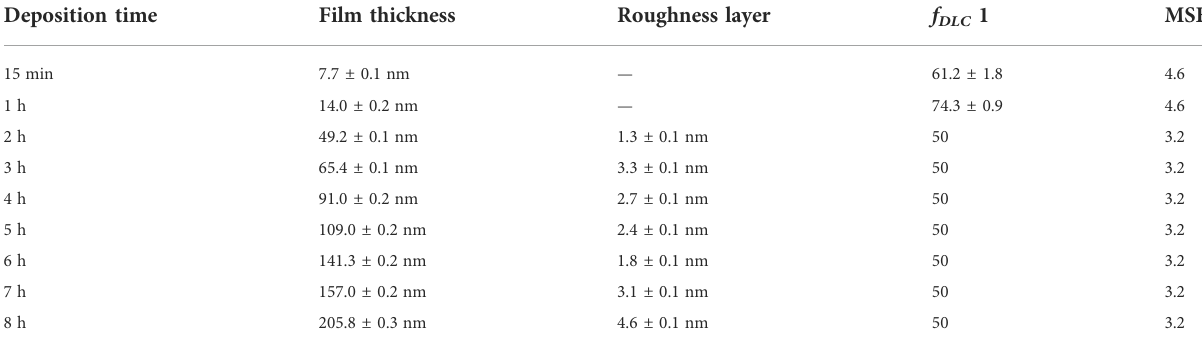
TABLE 2 Fitting results of DLC fi lms for different deposition time. Deposition